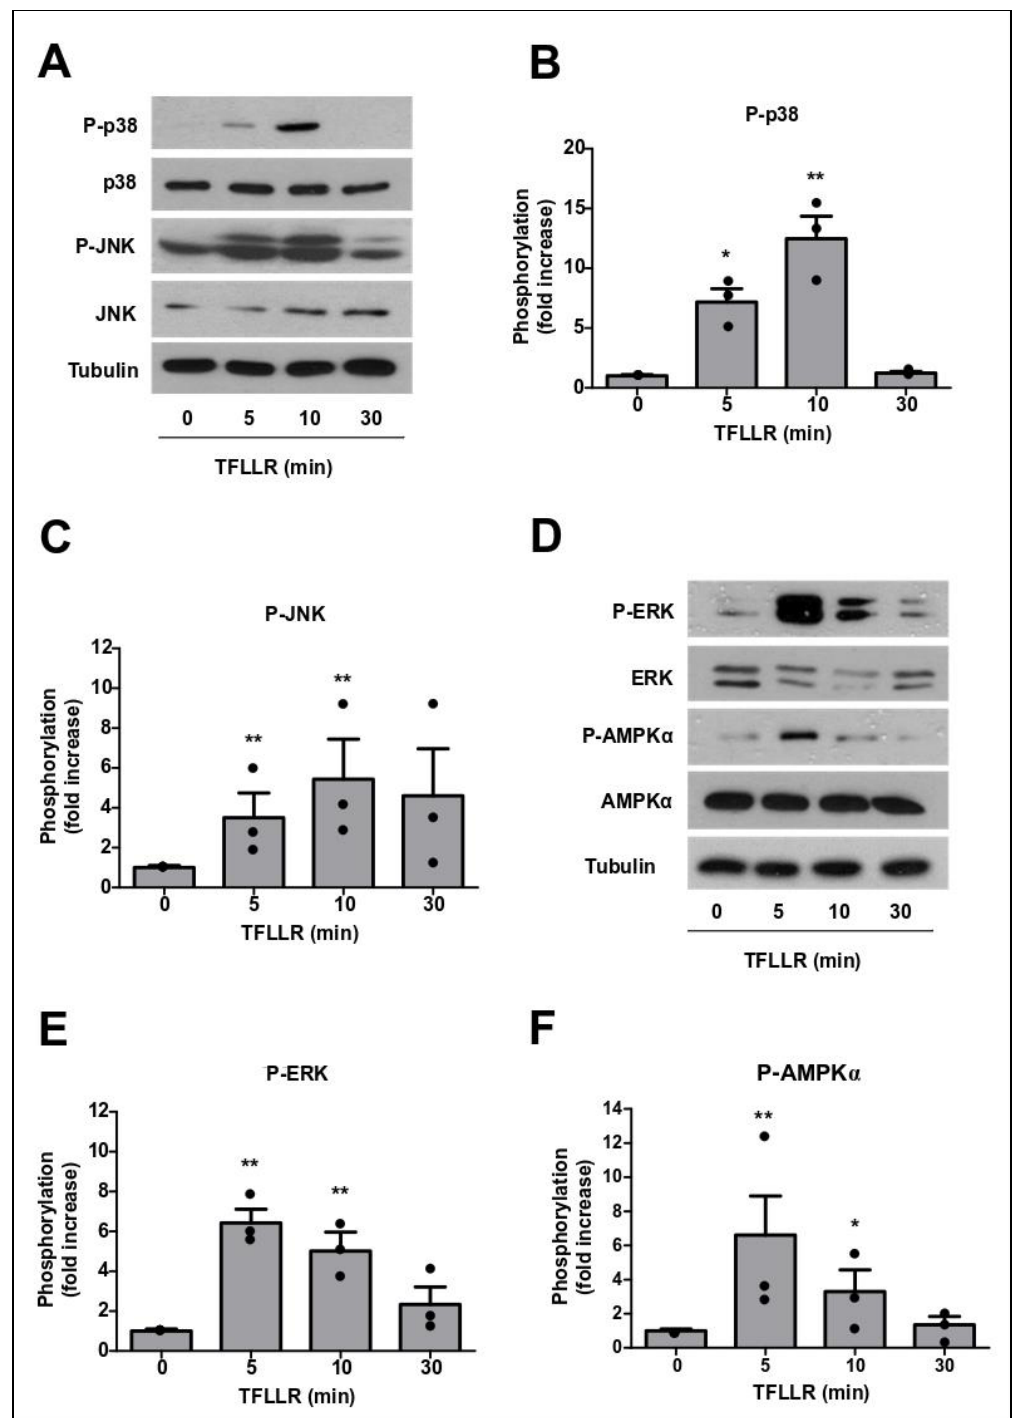
Figure 4. PAR1 activation in BBB endothelial cells leads to MAPK and AMPK phosphorylation. GPNT were stimulated with 100 µM TFLLR for the indicated length of time, and p38 ( A , B ), JNK ( A , C ), ERK ( D , E ) and AMPKα ( D , F ) phosphorylation was assessed by western blot. Representative results and quantification of protein phosphorylation, normalised to total protein levels, from three independent experiments are shown as means ± SEM. Each data point represents one independent, biological replicate. Significant di ff erences from controls were determined by ANOVA and Dunnett’s post-hoc analysis with * p < 0.05, ** p <